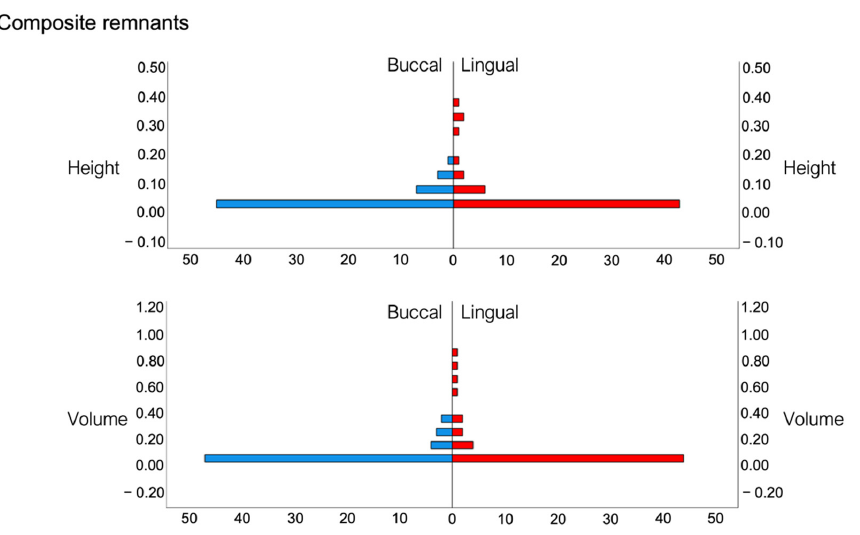
Figure 7. Composite remnant height ( top row ) and composite remnant volume ( bottom row ) values on the buccal (blue columns) and lingual (red columns) surfaces. (Height in mm; Volume in mm 3 ).